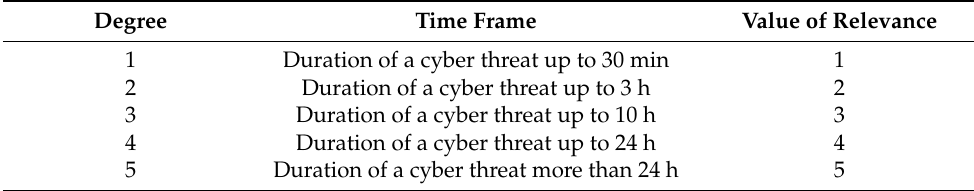
Table 2. Degrees of time frame (own